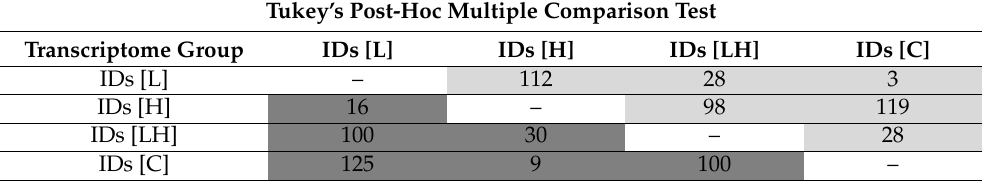
Table 2. The number of probe set identifiers (IDs) differentiating the examined transcriptome groups from each other.